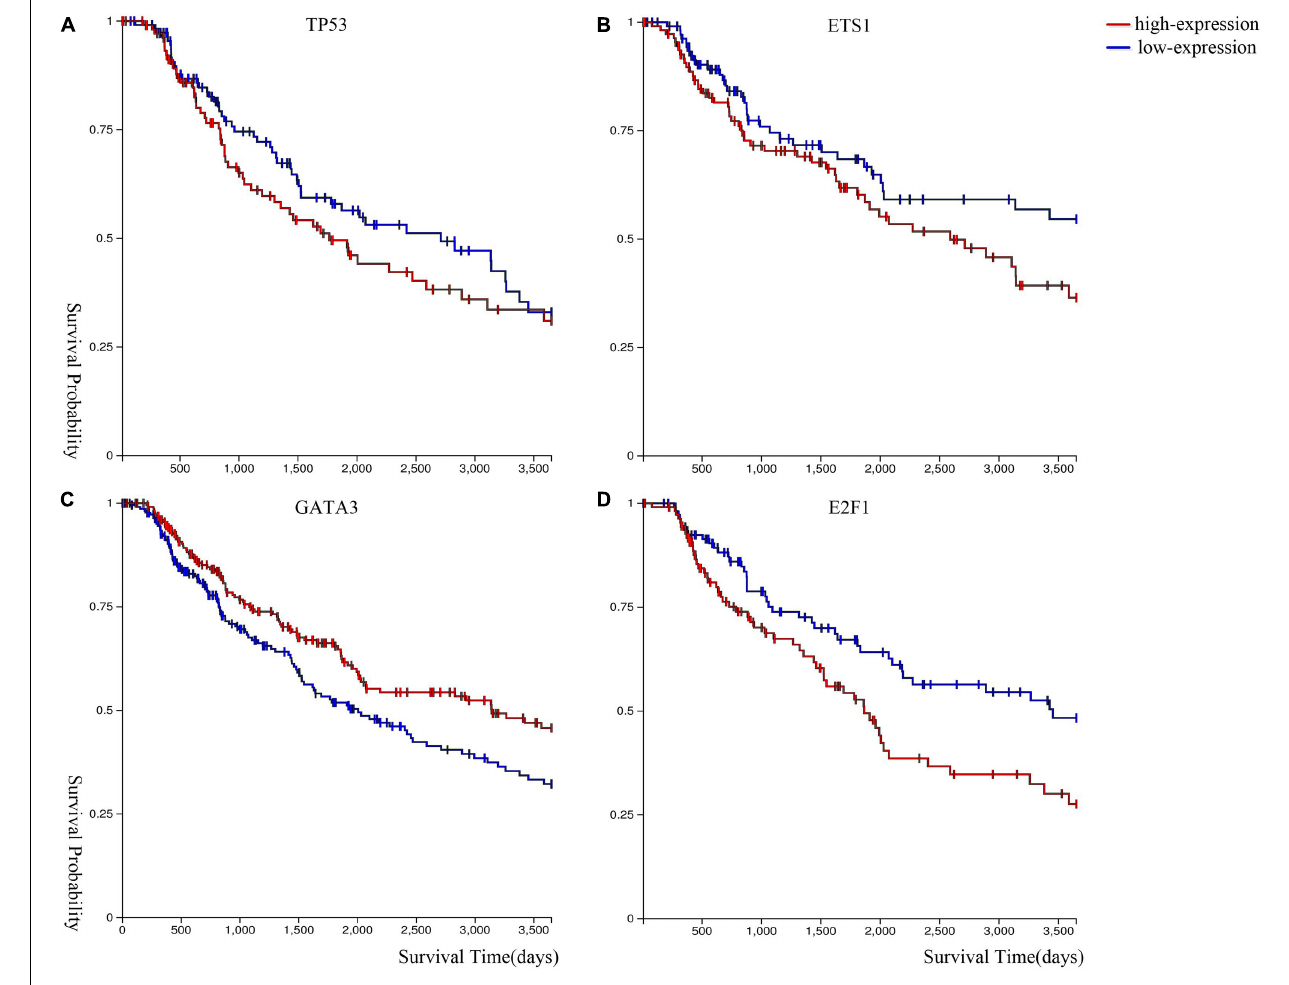
FIGURE 5 | Kaplan–Meier survival curves of (A) TP53 , (B) ETS1 , (C) GATA3 , and (D) E2F1